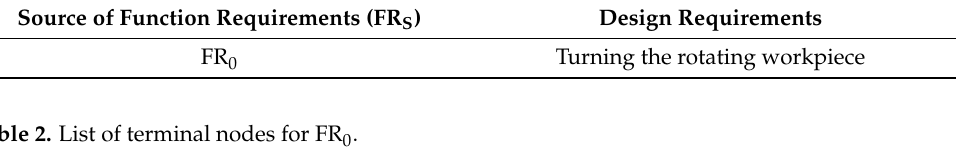
Figure 10. Schematic generation process diagram for FR 1 , FR 2 , and FR 3 . Table 1. List of FR 0 .